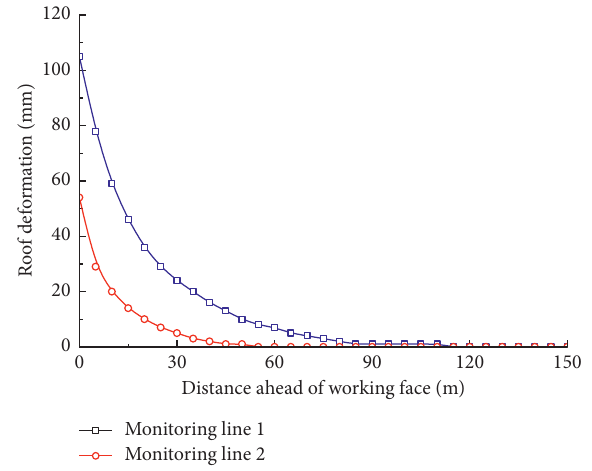
Figure 10: Roof deformation distribution curves in front of the working